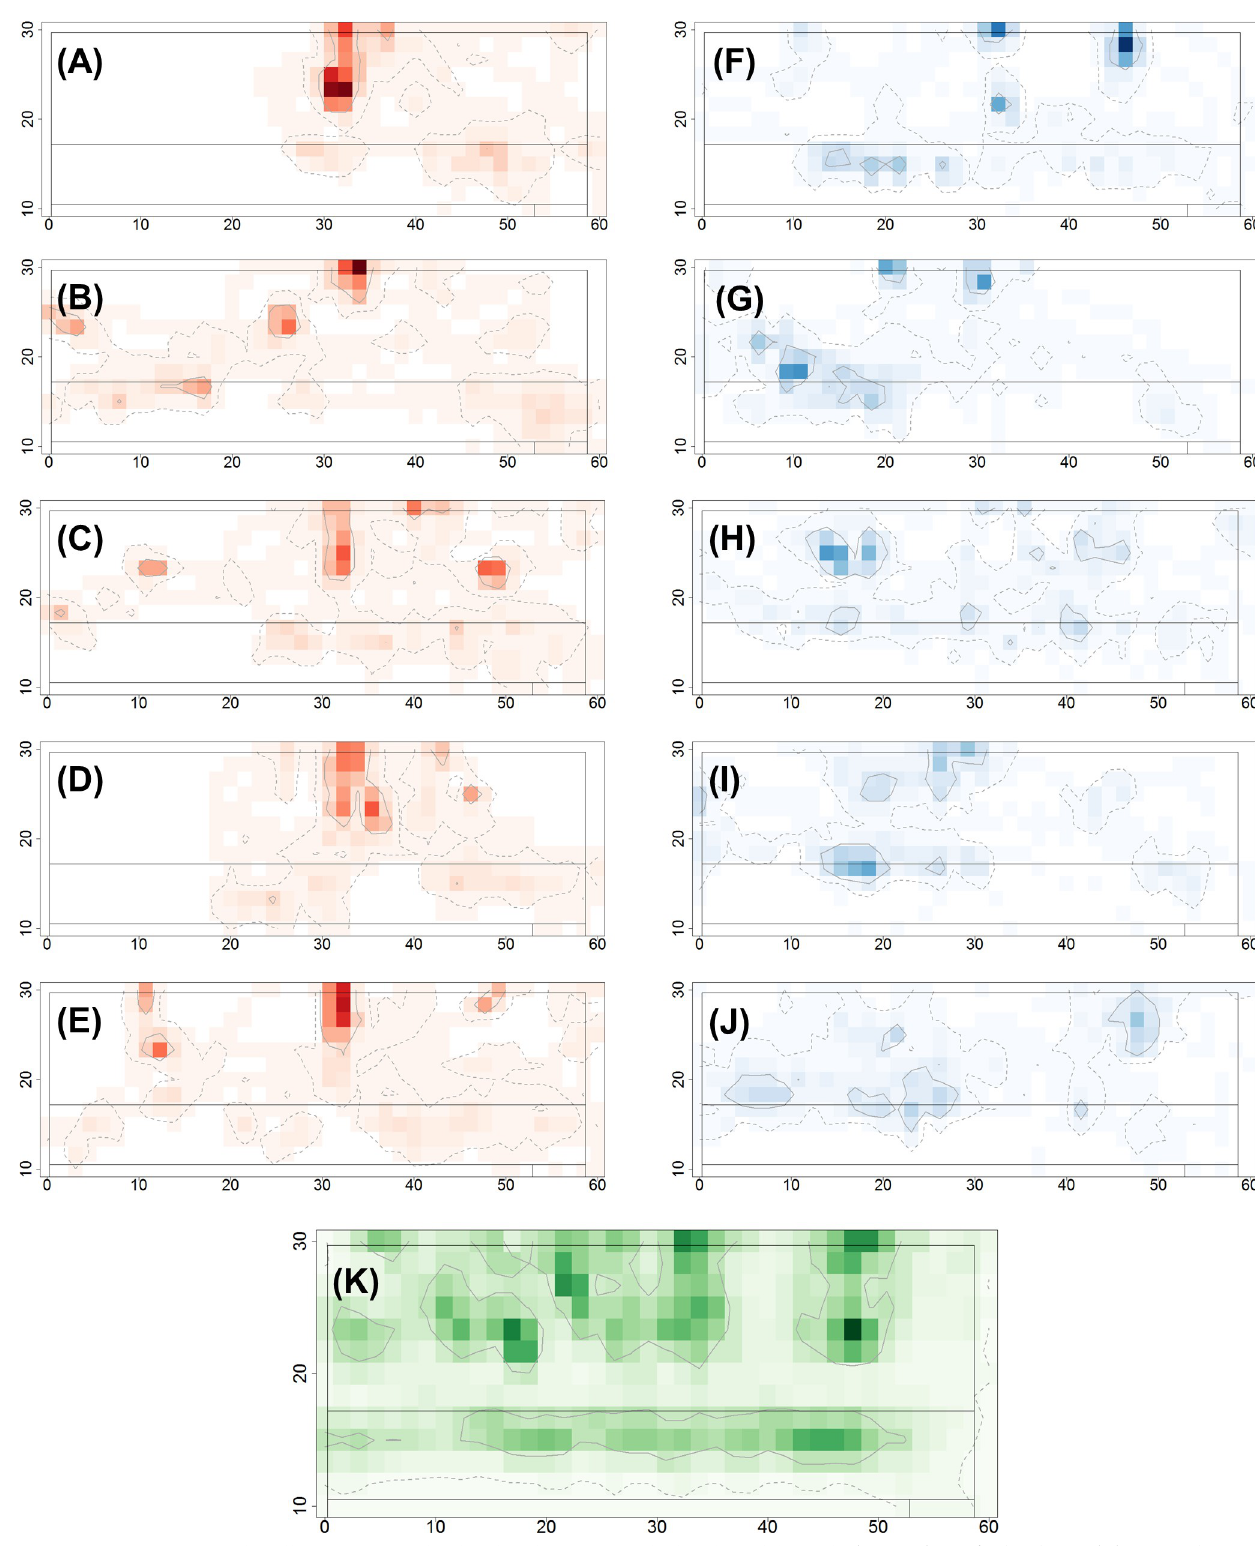
Fig 2. Space use intensity plots illustrating typical utility distributions over the five days of the trial. Plots are shown for (A-E) a single lame cow (cow 1078), and (F-J) a single non-lame cow (cow 2179), for each of the five days of the study. The space-use intensity UD is calculated by overlaying a 1.5m x